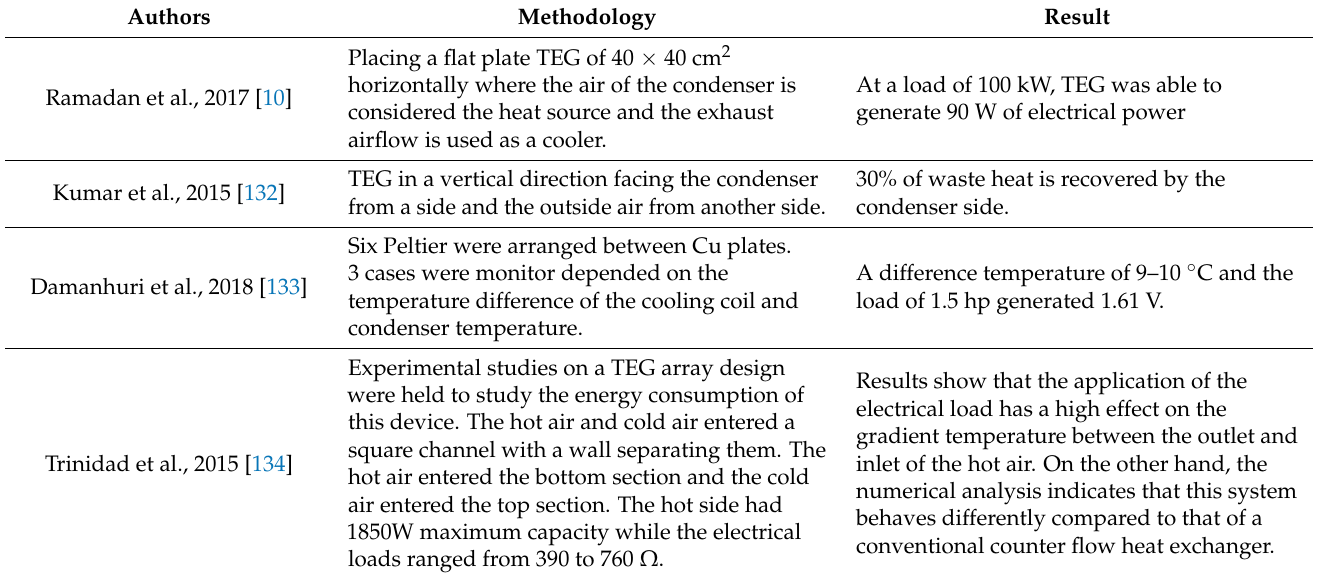
Table 3. Summary of the investigated papers related to generating electricity from the lost